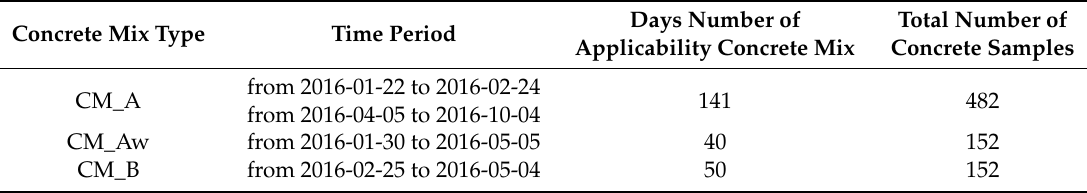
Table 2. The period of specimen